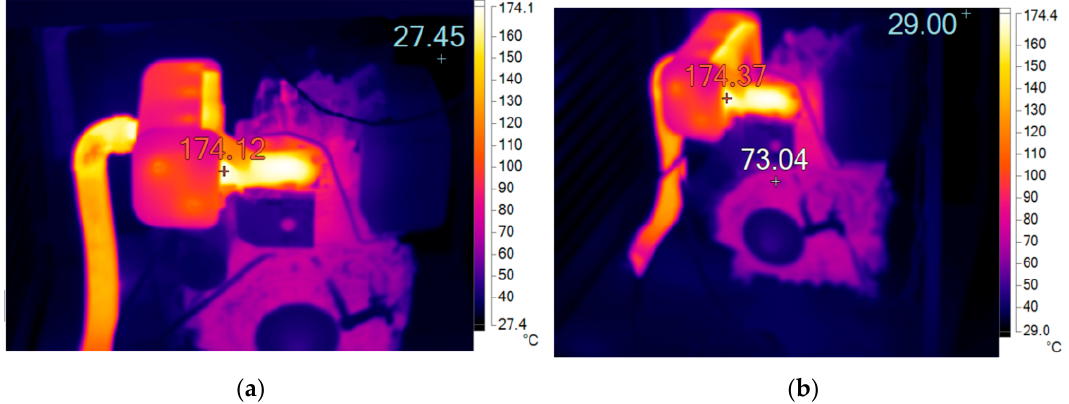
Figure 12. Maximum temperatures in the combustion chamber with the B5 mixture: ( a ) temperature in the chamber of 174.12 °C; ( b) temperature in the chamber of 174.37 °C.